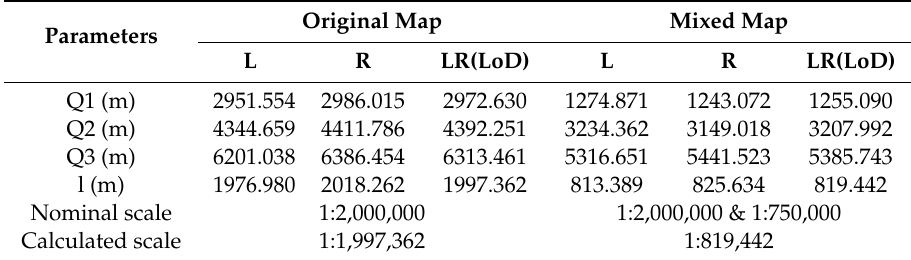
Table 5. Parameters for the original map and the mixed map.